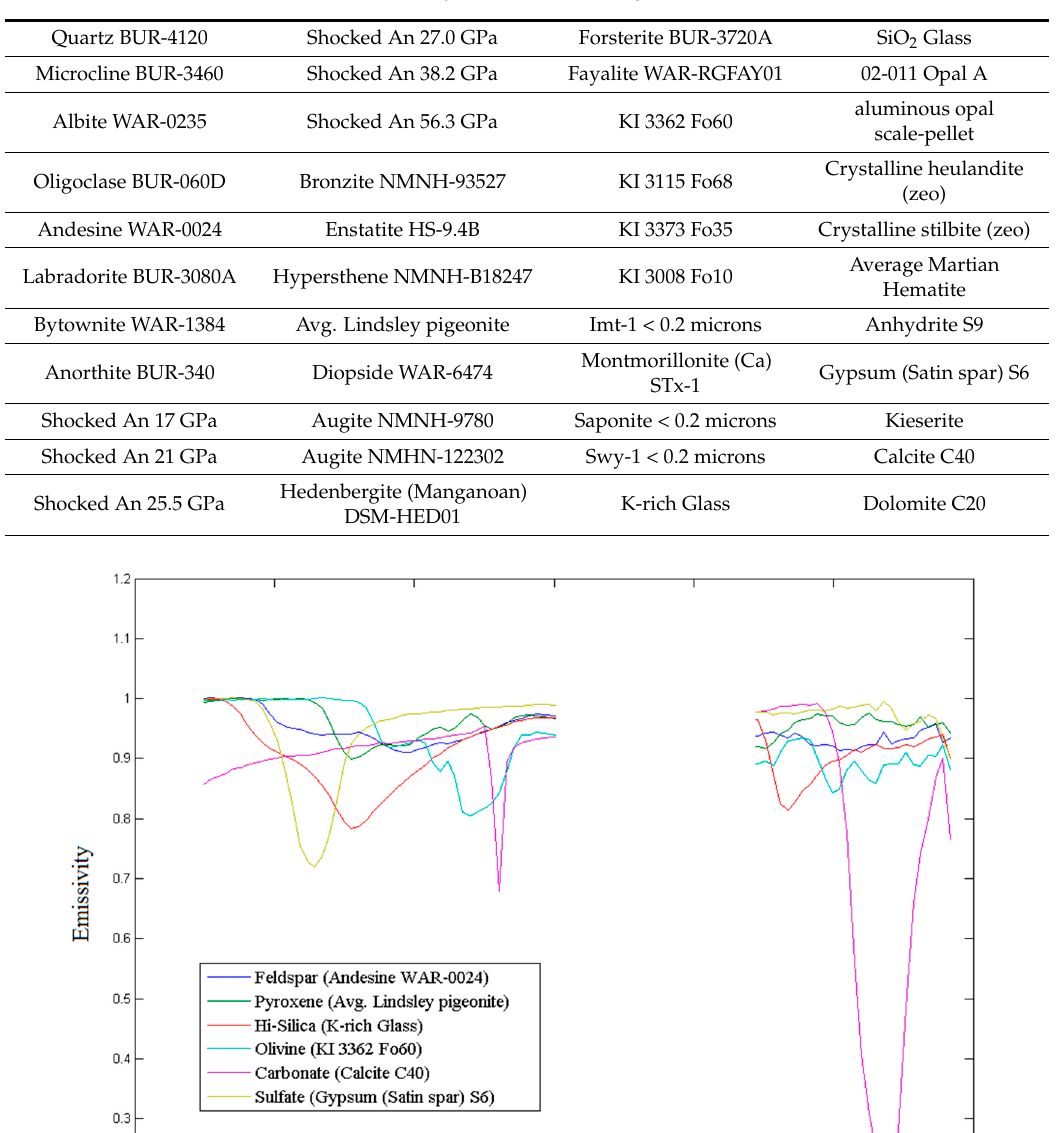
Table 3. Mineral library used for modeling Mars’ surface [80].